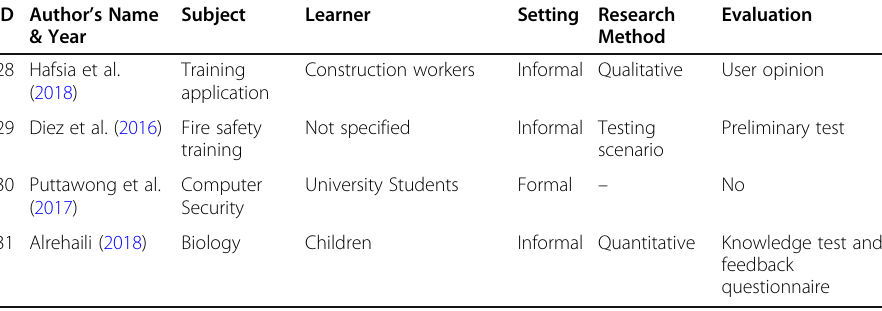
Table 7 Pedagogical characteristics of EVRGs